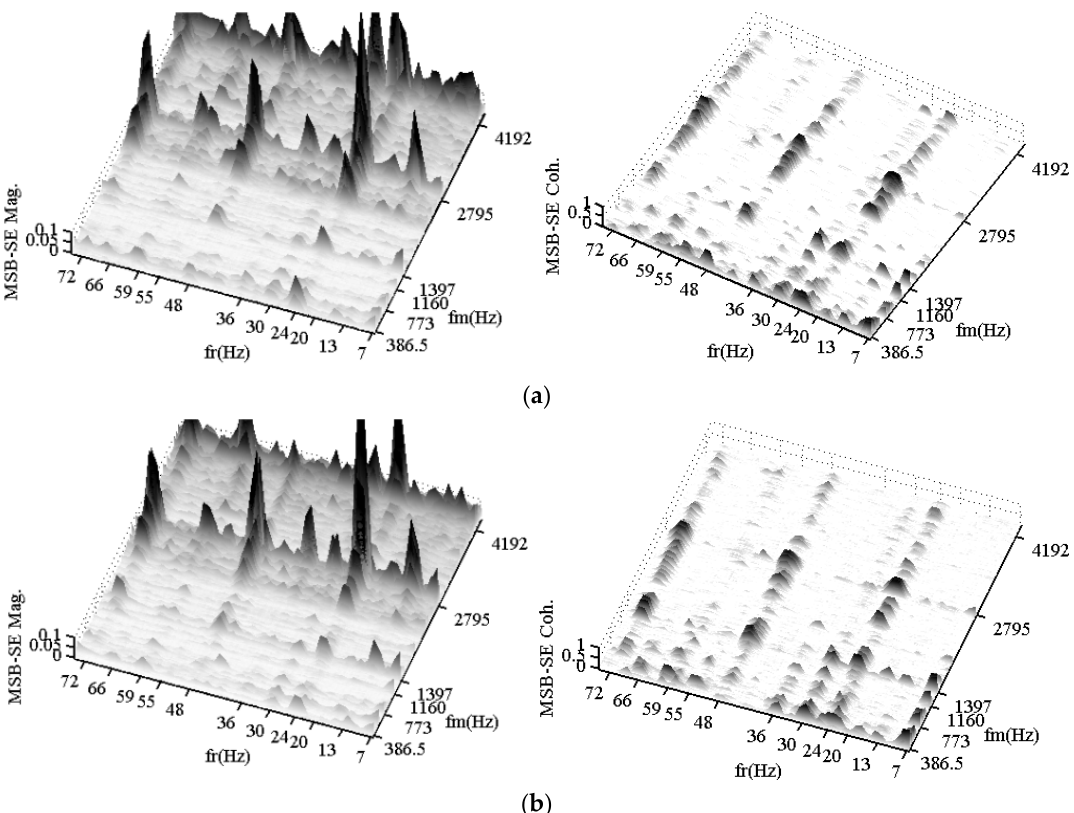
Figure 3. Modulation signal bispectrum ‐ based sideband estimator (MSB ‐ SE) magnitude and its coherence spectrum of different meshing frequency at the fourth hour under different loads. ( a ) MSB ‐ SE spectrum at Load = 80%; ( b ) MSB ‐ SE spectrum at Load = 90%.